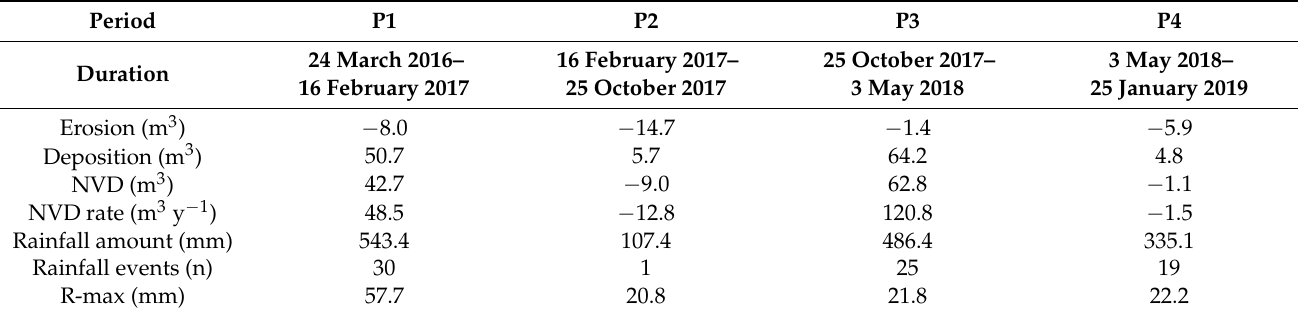
Table 3. Summary of the data registered during the study period: erosion or deposition, net volume difference (NVD), and rainfall variables (R-max = maximum event rainfall).